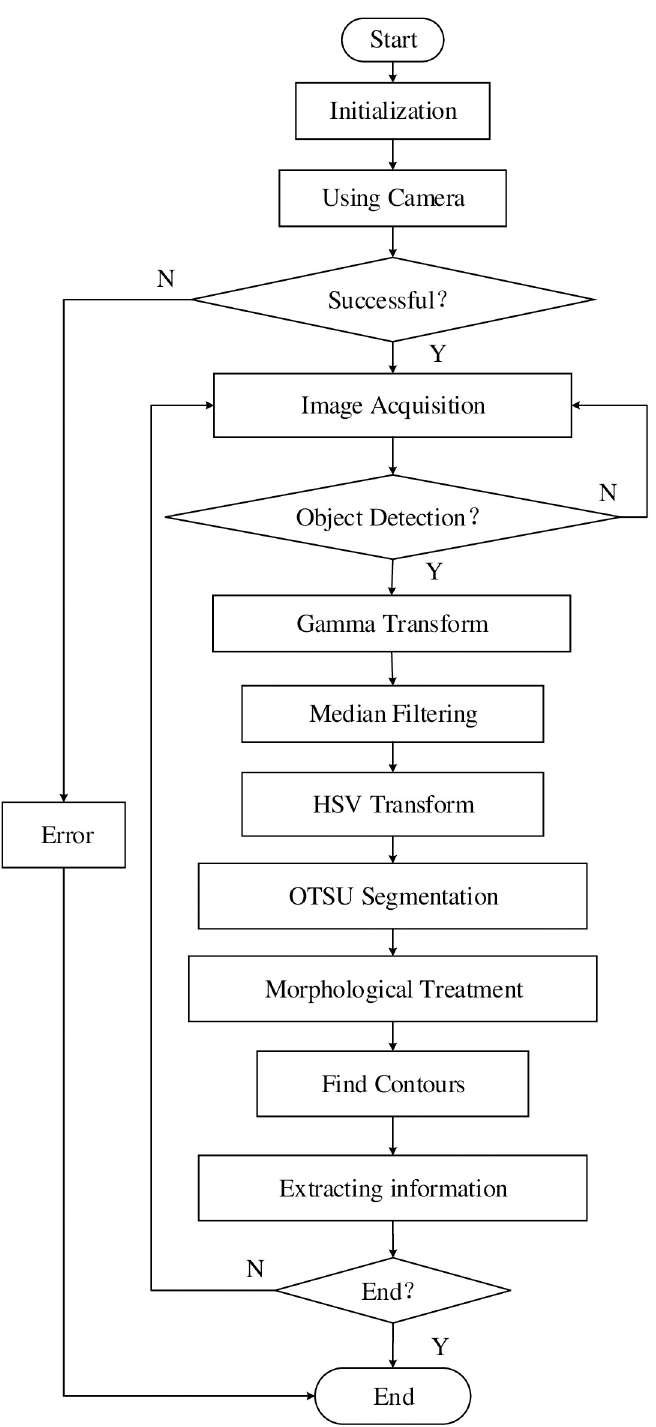
Fig 1. The flow chart of image acquisition and processing.